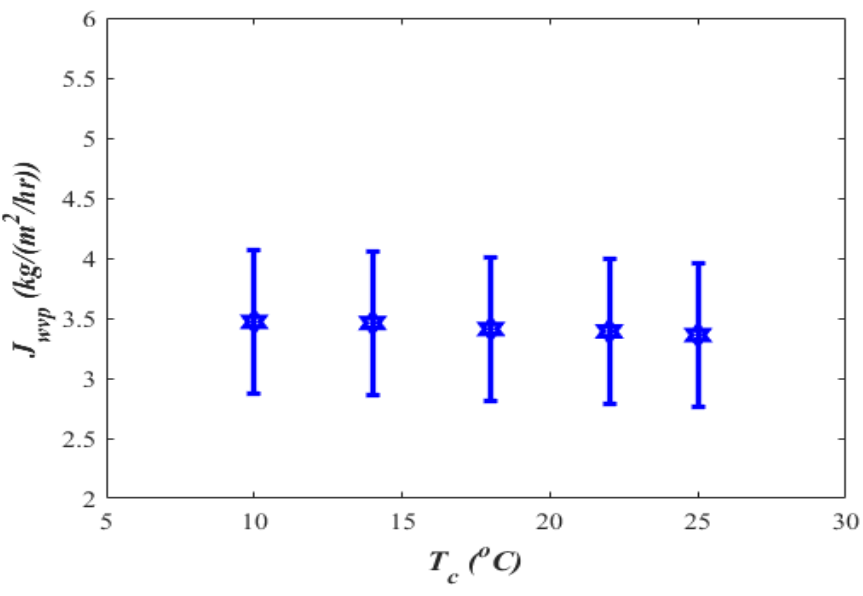
Figure 17. J wvp at different cold feed temperatures (T c ).